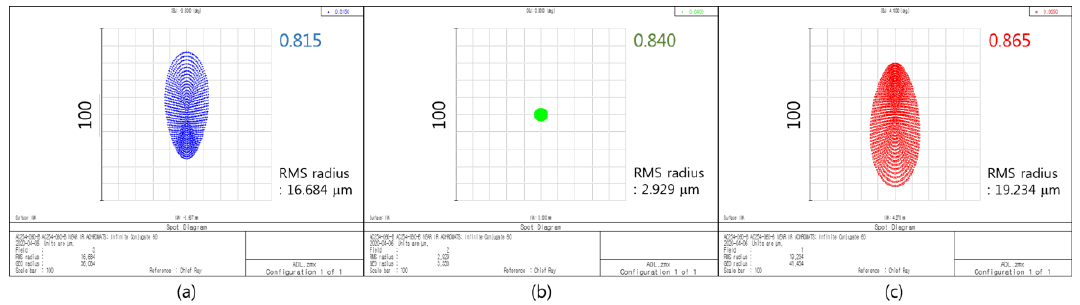
Figure 4. Spot diagram of the ADL at ( a ) the edge wavelength of 815 nm, ( b ) the center wavelength of 840 nm, and ( c ) the edge wavelength of 865 nm. The plot scale is 100 µ m. The number on the right top is the wavelength used for calculation.